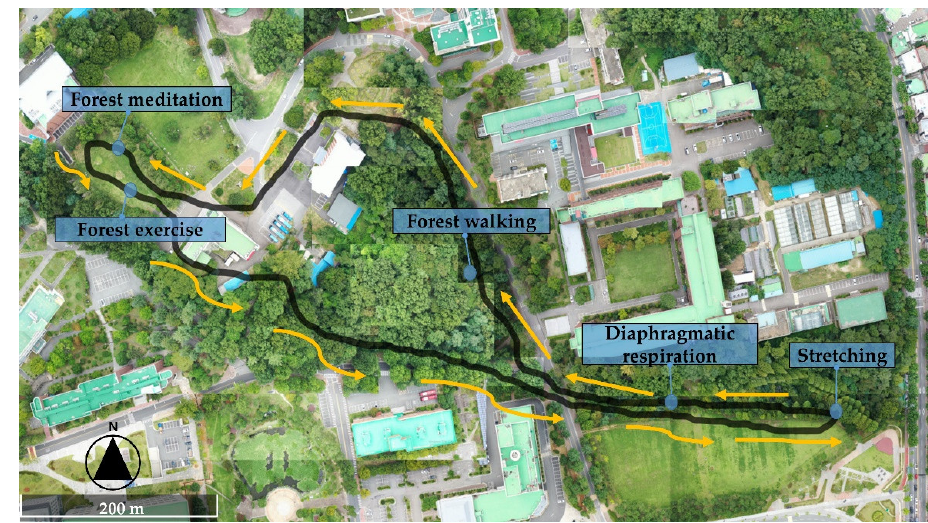
Figure 1. Maps of the campus forest activities trail in this study.